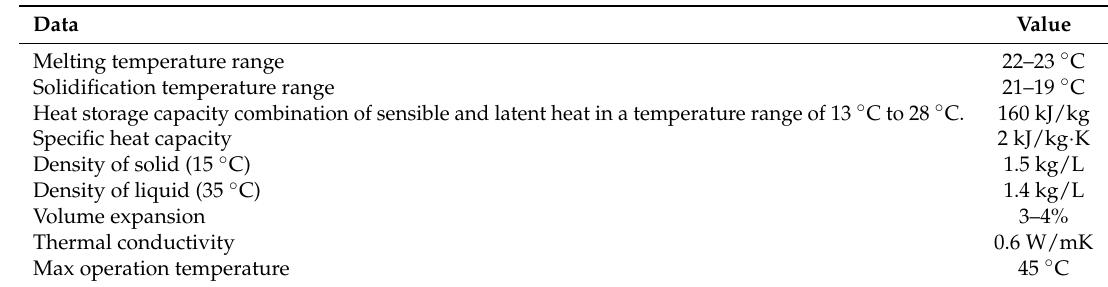
Table 1. SP21E phase change material (PCM) panel characteristics.